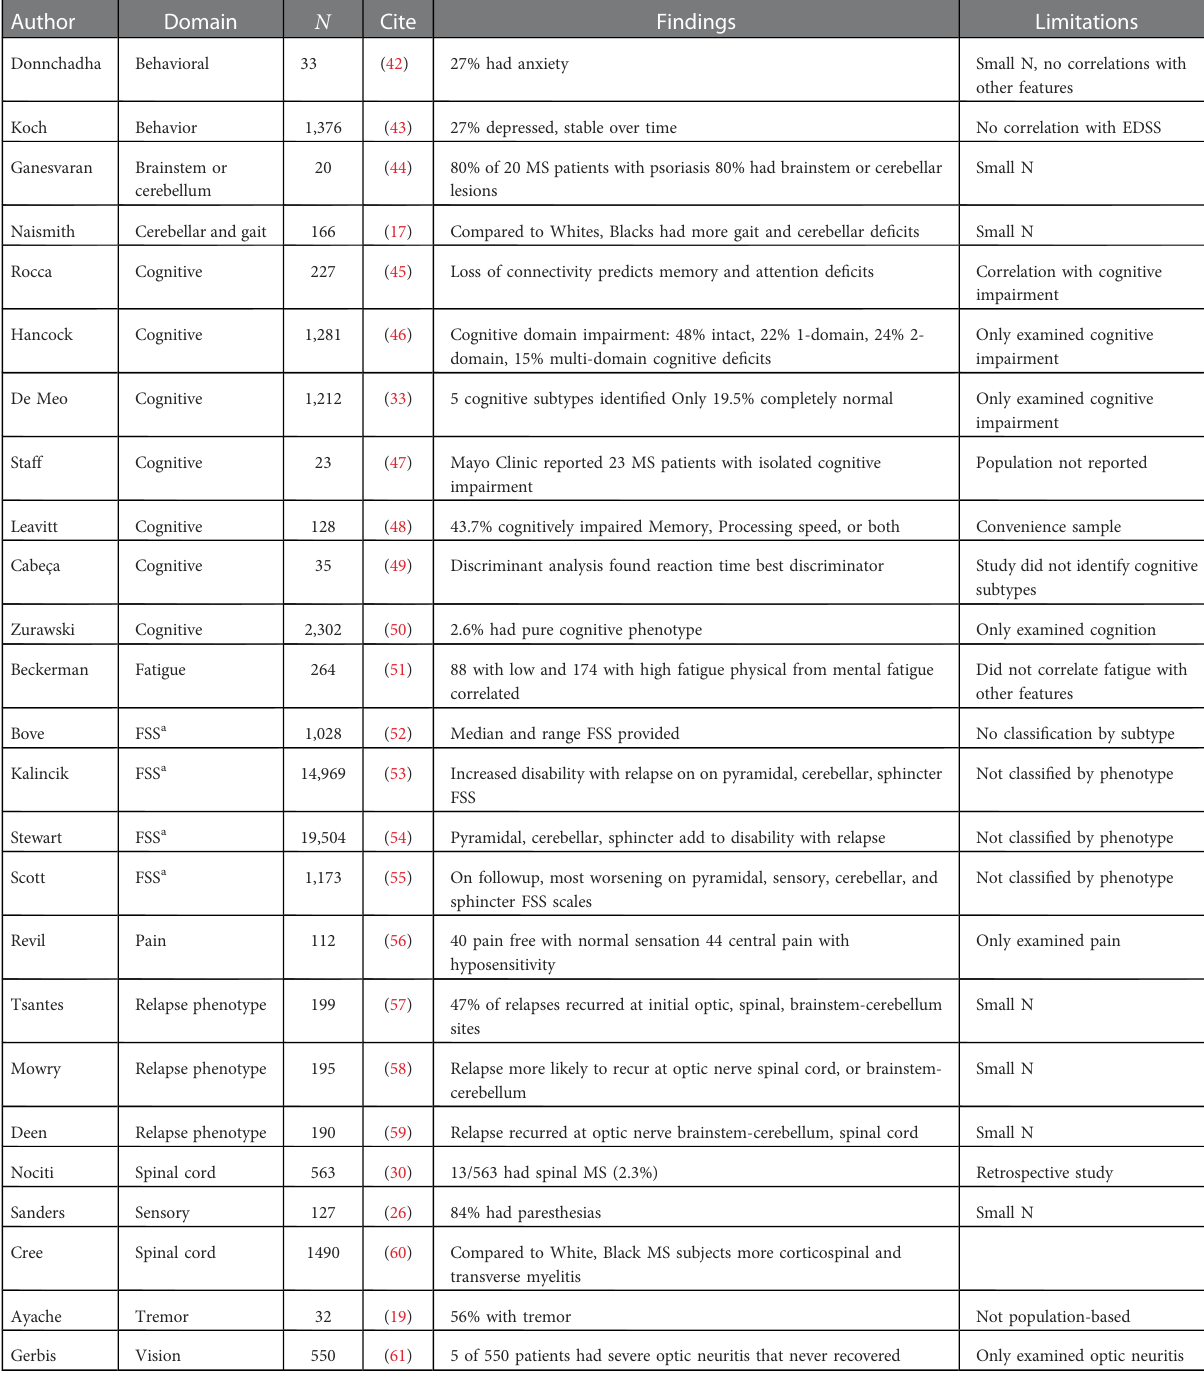
TABLE 1 Summarization of prior work relevant to subtyping multiple sclerosis by phenotypic